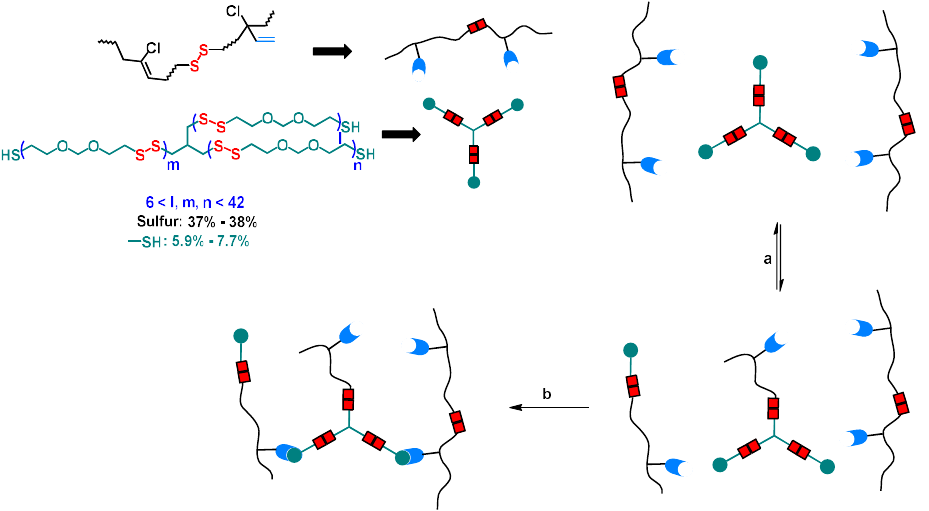
Table 3. Values of M n , M w and PD obtained from GPC data